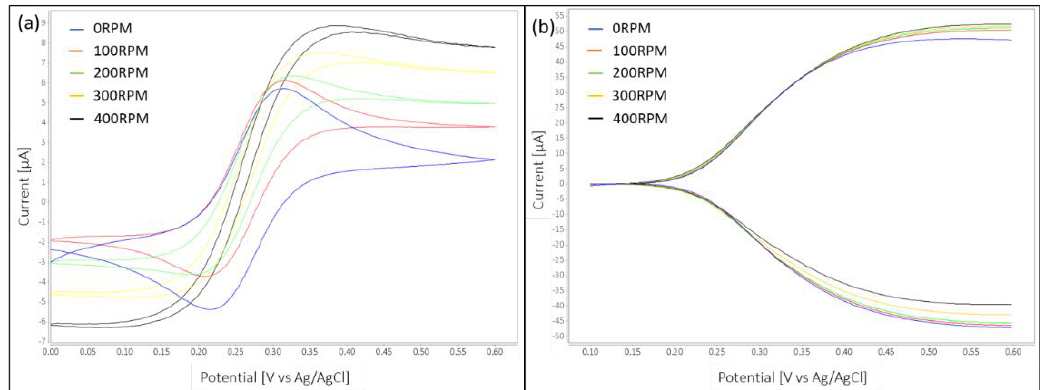
Figure 4. ( a ) Single mode platinum IDA CV for increasing flowrates. The behavior changes from diffusion limited to reaction limited for higher flow rate, ( b ) Dual mode CV for platinum IDA for different flowrates. The baseline was subtracted from curves in dual mode for better visibility of the current increase with increasing flowrate.